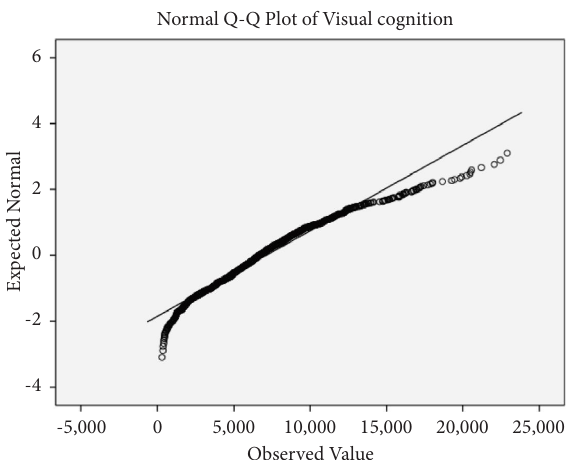
Figure 6: Driver’s visual cognition data Q-Q